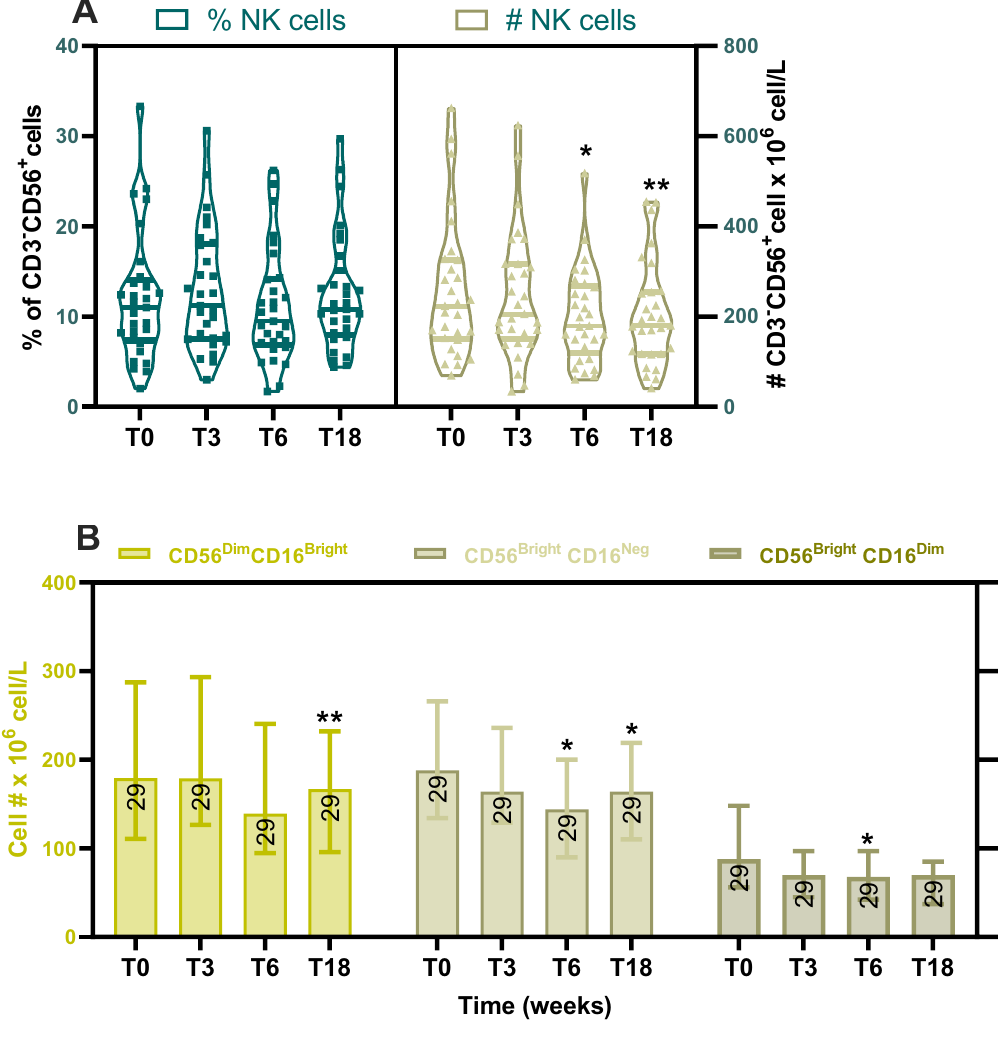
Figure 2. Ranitidine treatment is associated with a decrease of NK cells: The percentage and number of peripheral blood total CD3-CD56 + NK cells ( A ) and their subsets CD56 bright CD16 neg , CD56 bright CD16 dim cells and CD56 dim CD16 bright NK cells subsets ( B ) were assessed before ranitidine treatment (T0), after 3- and 6-weeks treatment (T3 and T6), and 12 weeks after treatment cessation (T18) by flow cytometry. Statistical analysis was performed using repeated measures Friedman’s test with Dunn’s multiple comparison using T0 as control (A and B) and t-test to compare immunoglobulin level at T0 and T6. Graphs depict median and IQR, n = 29. *P < .05; **P <